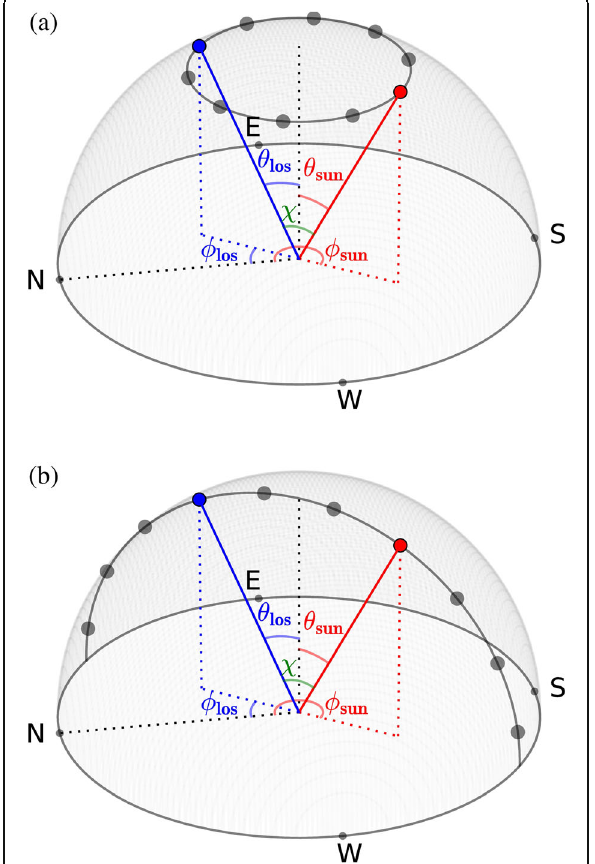
Fig. 3 Schematic figures of observation geometry on ( a ) almucantar plane and ( b ) principle